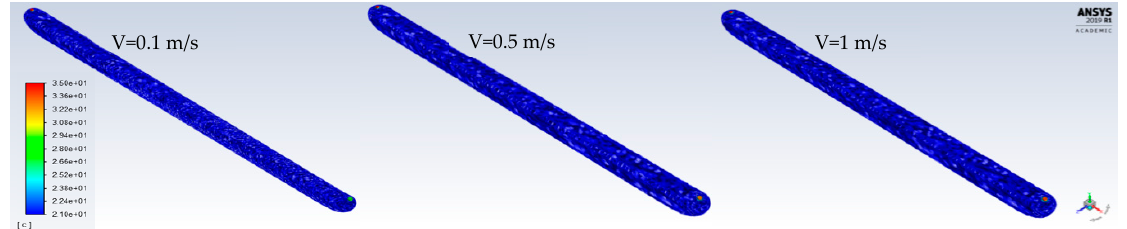
Figure 7. Soil temperature (shown if it is above 21 °C) for T Inlet = 35 °C.